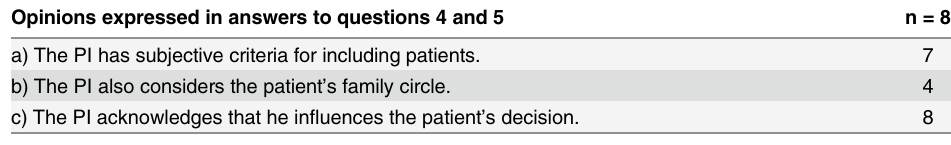
Table 4. Opinion of principal investigators about patients' inclusion in RCTs. Opinions expressed in answers to questions 4 and 5